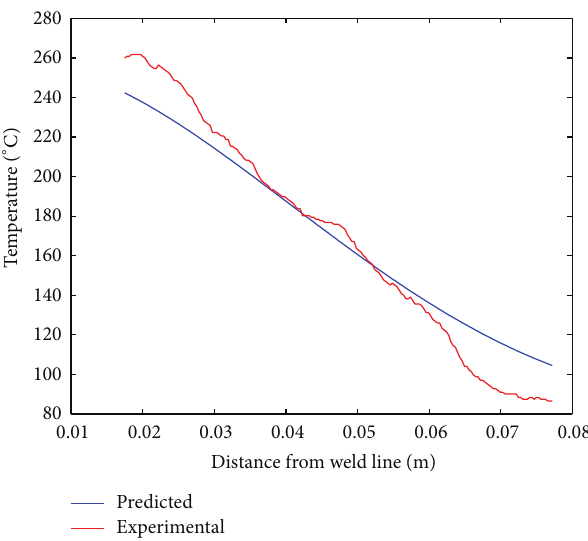
Figure 12: Temperature plot at 𝑡 = 115 sec along midline.